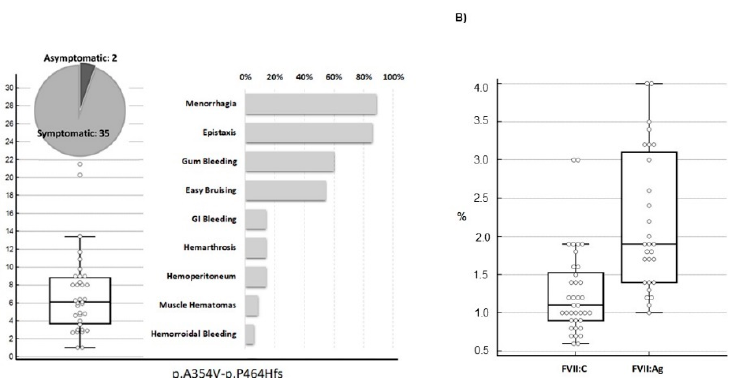
Figure 1. Clinical presentation in homozygous patients for the p.A354.p.P464Hfs mutation. ( A ) Age at first symptom and prevalence of type of hemorrhage in patients homozygous ( n = 37, females n = 26) for the compound p.A354.-p.P464Hfs mutation. Symptom prevalence is reported in relation to the number of symptomatic homozygotes ( n = 35). Menorrhagia prevalence is indicated in relation to female homozygotes. ( B ) FVII activity ( n = 37) and FVII antigen ( n = 28) values in the p.A354.p.P464Hfs homozygotes. Data are presented as box plots. FVII:Ag, FVII antigen; FVII:C, FVII procoagulant